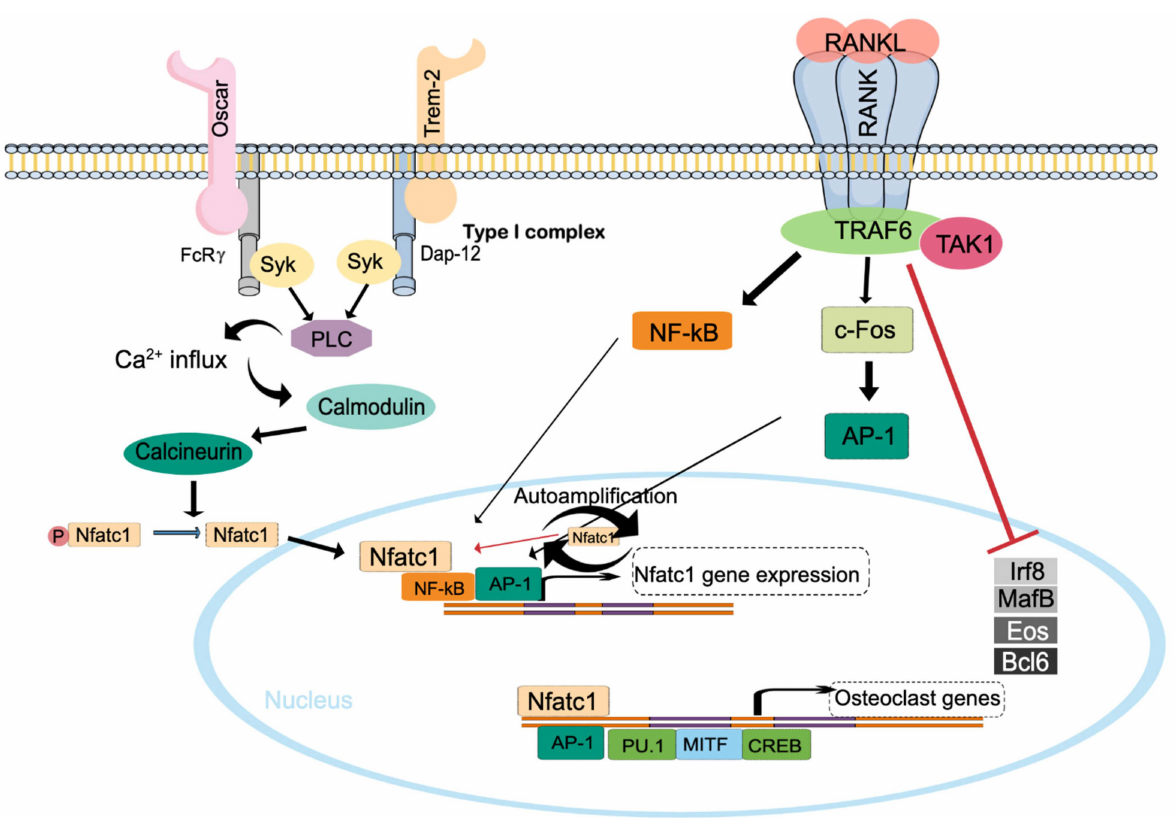
Figure 2. Osteoclastogenesis depends on the binding of RANKL to the trimeric receptor RANK and on co-stimulatory signals triggered by FcRy and Dap12 that dimerize with OSCAR and Trem- 2, respectively. While RANK activation induces activation of important stimulatory transcription factors including CREB, AP-1, PU.1, Nfatc1, and MITF that regulate the expression of osteoclast genes, it downregulates other transcription factors such as Irf8, MafB, Eos and Bcl6. Meanwhile, signal through FcRy and Dap12 subunits activate PLC, which enhances intracellular calcium and thereby stimulates calmodulin and calcineurin. Calcineurin dephosphorylates Nfatc1, regarded as the